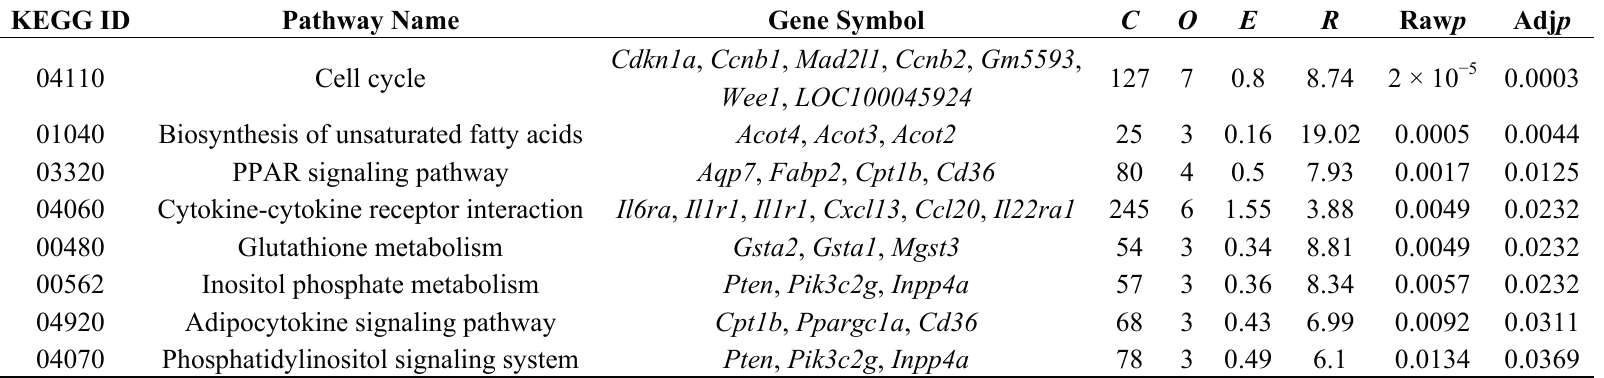
Table 3. Kyoto Encyclopedia of Genes and Genomes (KEGG) pathways with differentially expressed genes in the high-fat diet offspring (fold change > 2.0, p < 0.05).